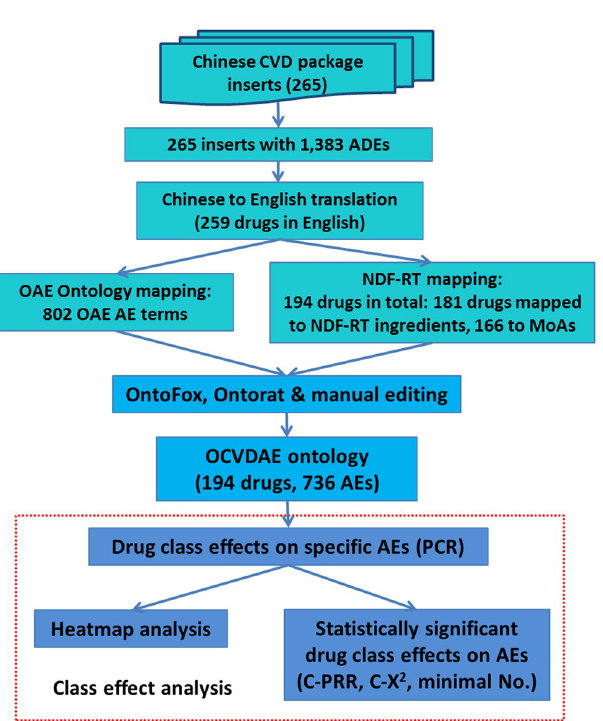
Figure 1. Workflow of our ontology-based cardiovascular drug class level effects on different adverse events (AEs). The results of collected CVDs, associated AEs, and ontology mappings are also labeled in this